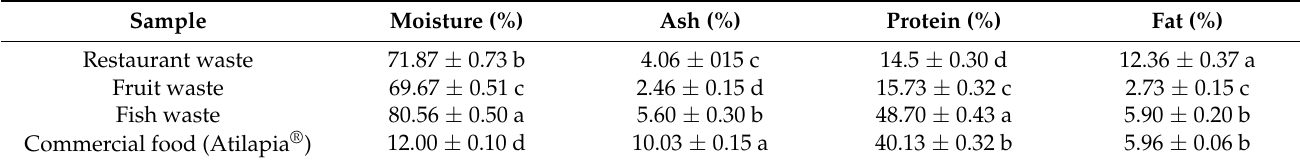
Table 2. Substrate chemical